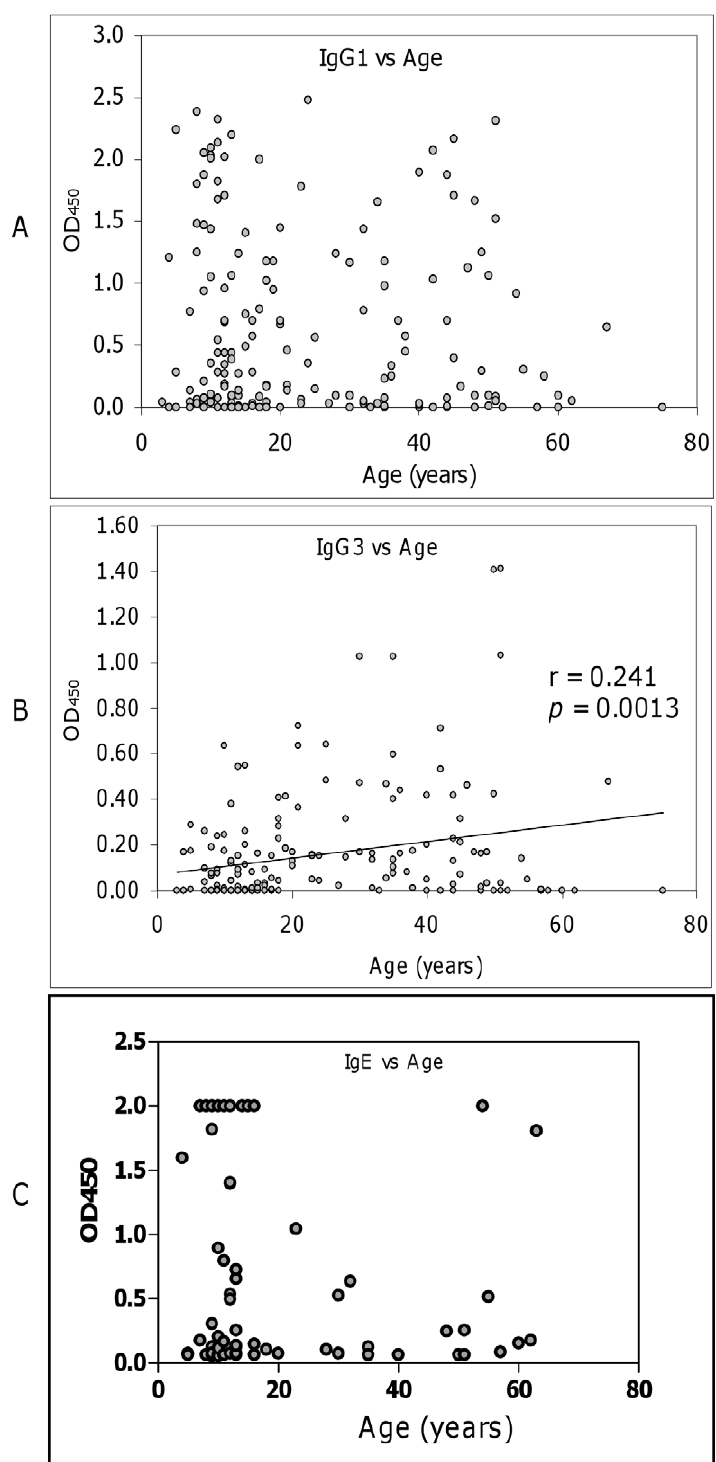
Figure 1. The correlation of IgG sub-classes and IgE class responses to r Ov -CPI-2 in infected patients with age: Maintenance of high IgG1 (a) and IgE (c) responses regardless of age; (b) Positive correlation between IgG3 levels and age (r=0.241; P